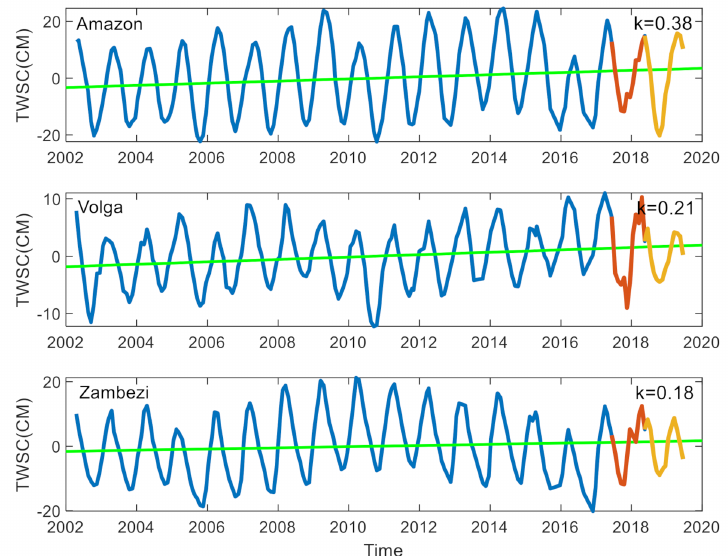
Figure 9. The GRACE-Swarm-GFO-TWSC time series and long-term (April 2002 to June 2019) in the Amazon basin, the Volga basin and the Zambezi basin. The blue line is the GRACE-TWSC time series, the red line is the Swarm-TWSC, the orange line is the GFO-TWSC and the green line is the long time TWSC trend of each